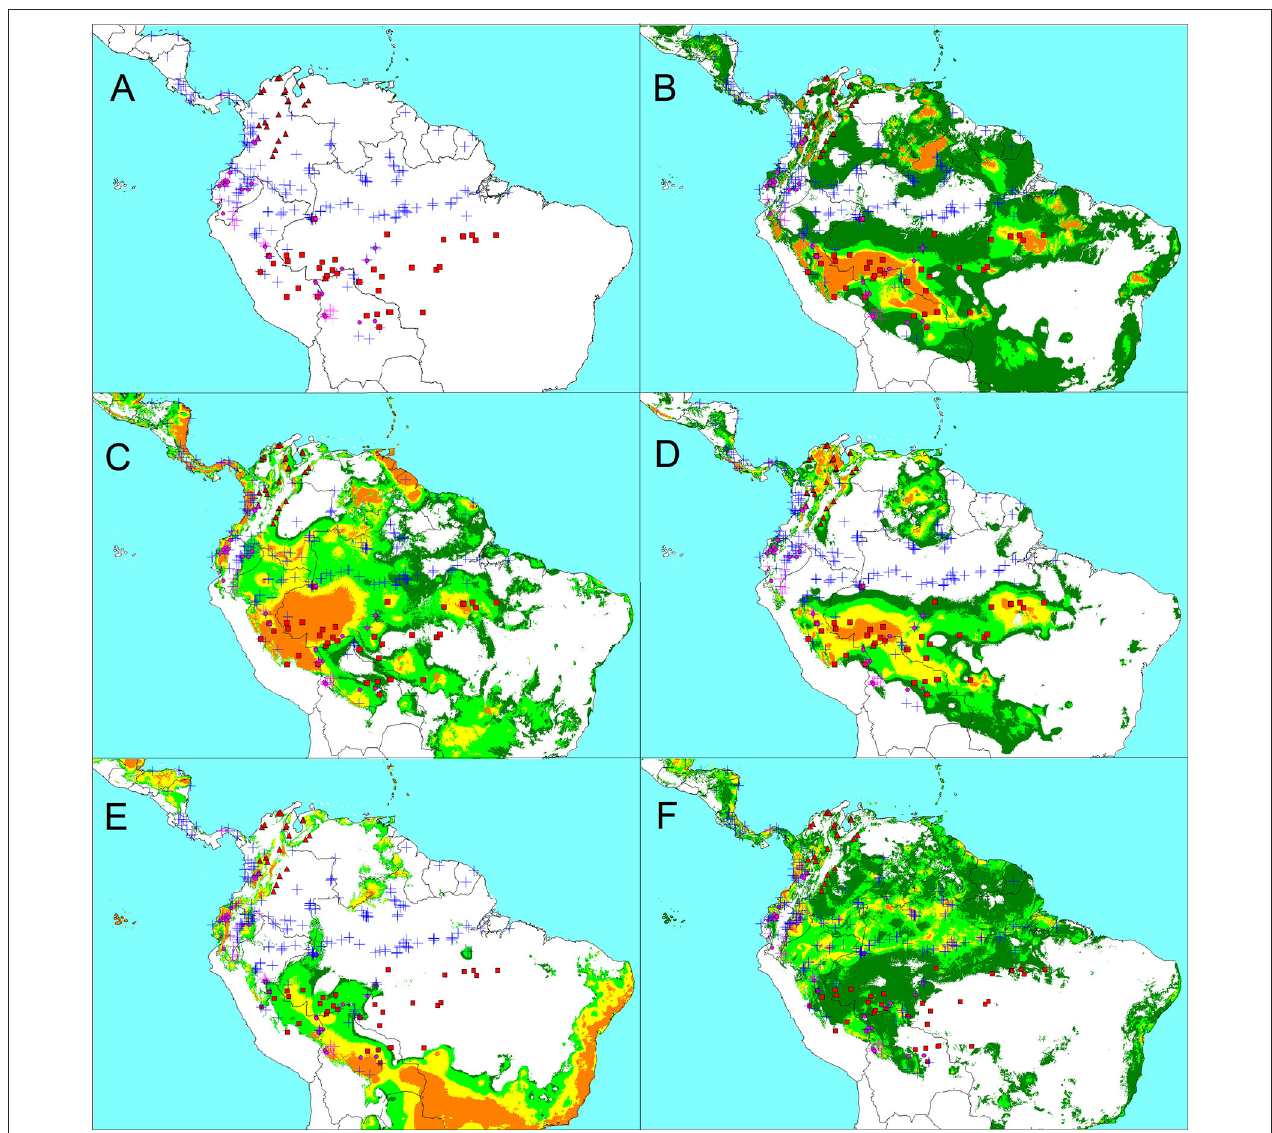
FIGURE 2 | Distribution of wild and cultivated Bactris gasipaes samples used in our models (A) , and modeled distributions, based on current Worldclim conditions, of wild peach palm, var. chichagui type 1 (B) , type 2 (C) , a combination of types 1 and 2 (D) , the incipient domesticate var. chichagui type 3 (E) , and var. gasipaes (F) . Colors indicate climate suitability according to logistic thresholds (dark green below 10% training omission, light green above this 10% threshold, yellow above 33% threshold, orange above 67% threshold). Symbols: red squares, var. chichagui type 1; red triangles, var. chichagui type 2; magenta circles, var. chichagui type 3;